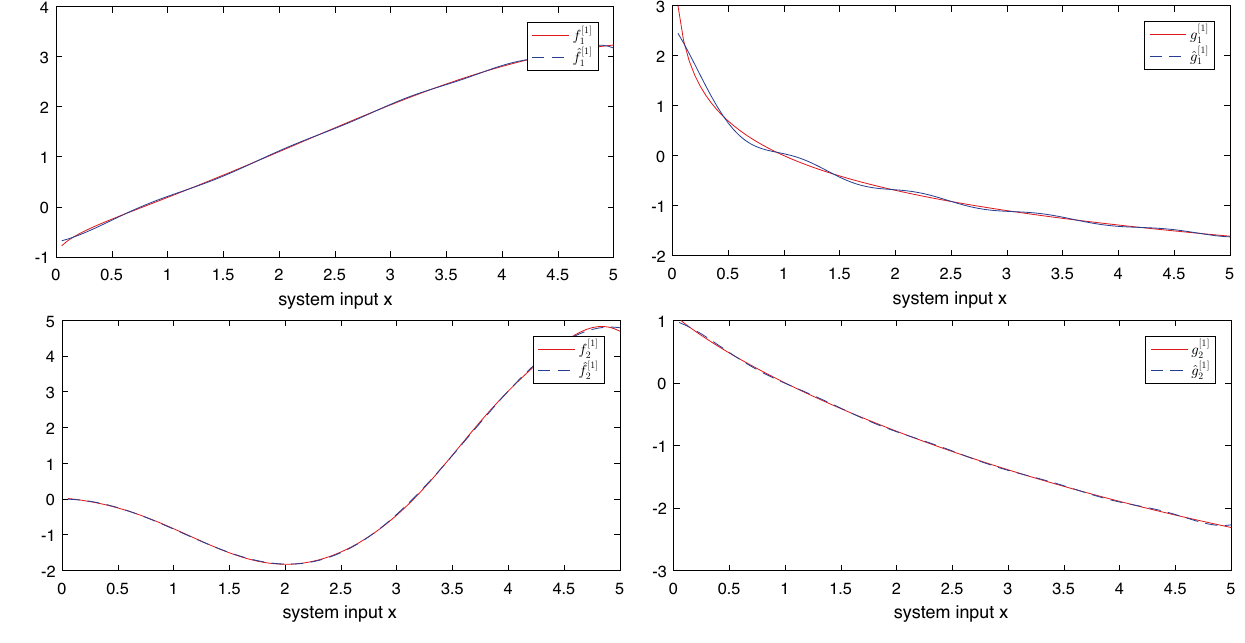
Figure 4. Uncertain functions and its RBFNN approximation values of subsystem 1.